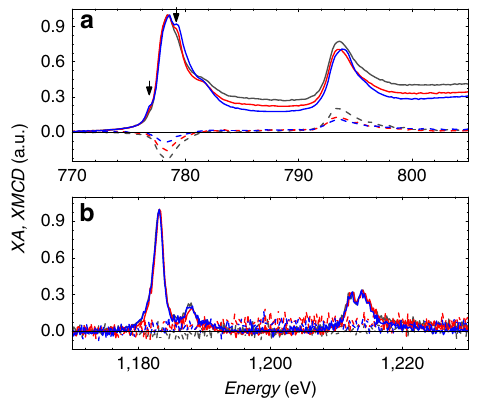
Figure 4 | X-ray absorption and XMCD spectra. XA (solid) and XMCD (dashed) spectra for ( a ) cobalt and ( b ) gadolinium in samples as-grown (grey), after þ / (cid:2) 40V conditioning (E þ T, red) and thermal-only (blue) conditioning. Arrows indicate 779.2eV